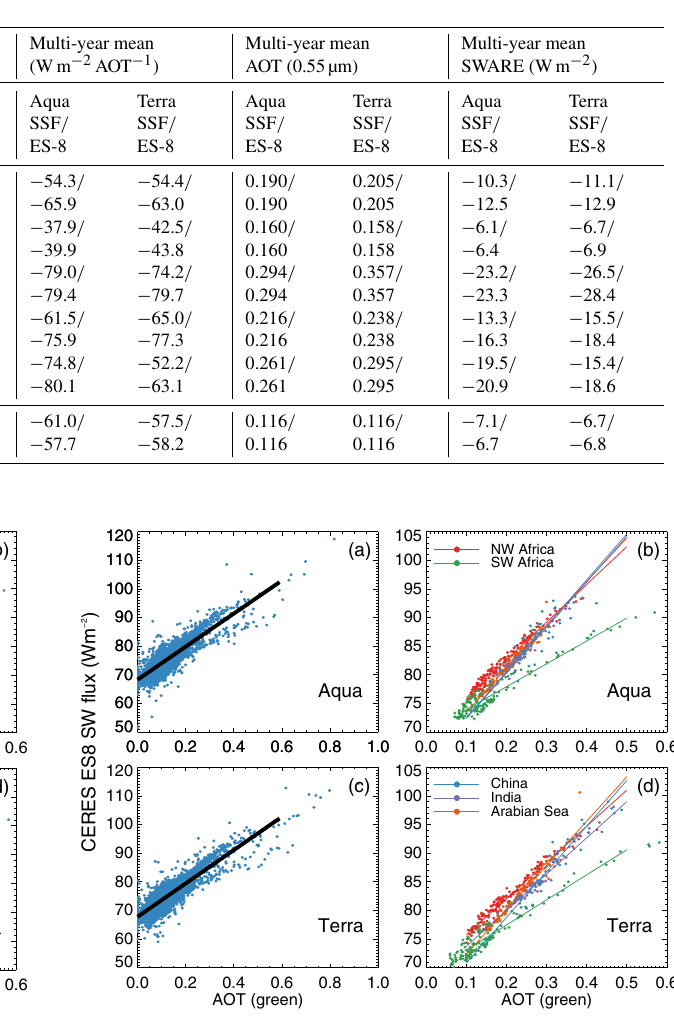
Figure 7. Similar to Fig. 6, but for using collocated MODIS and CERES ES-8 cloud-free SW flux